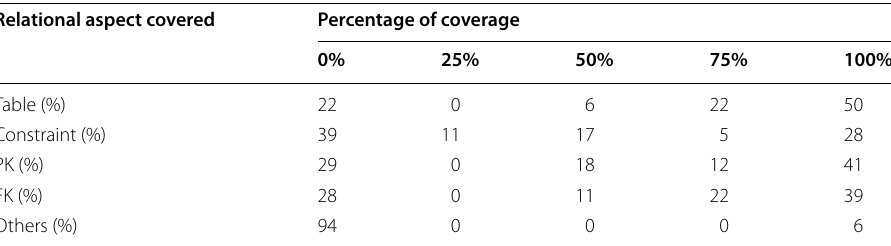
Table 4 Level of coverage in different DB aspects Relational aspect covered Percentage of coverage